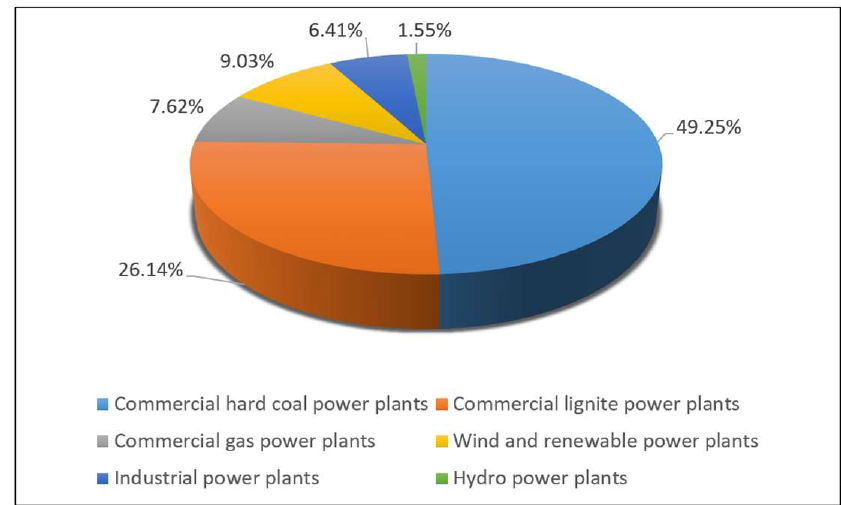
Figure 5. Renewable energy production in Poland in 2019.